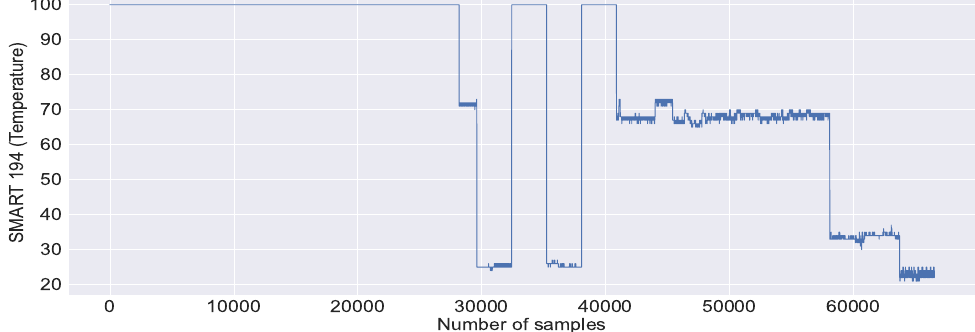
Figure 2. SMART 194 data distribution visualisation.